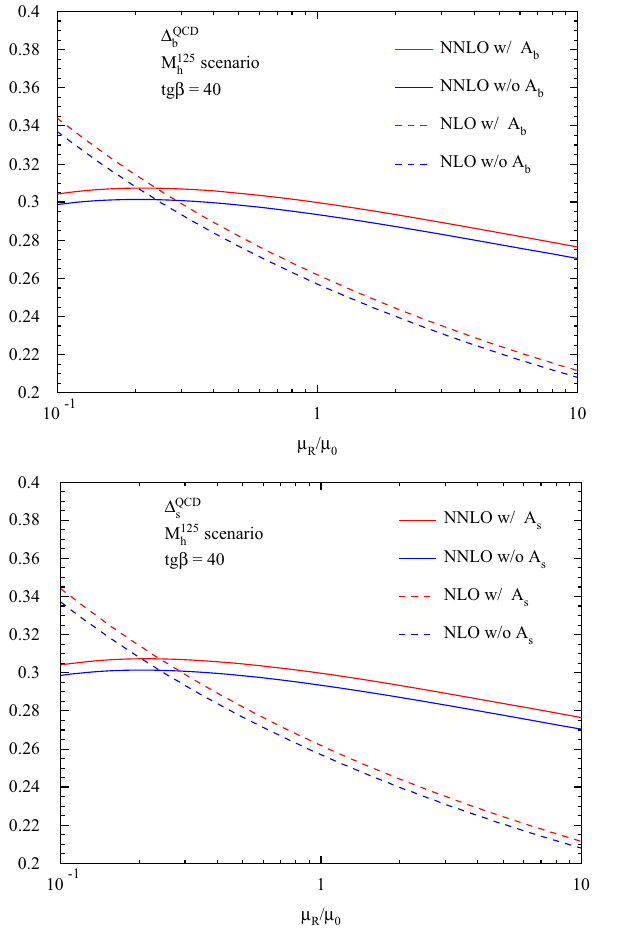
Fig. 8 Dependence of the full SUSY–QCD + SUSY–electroweak cor- Fig. 7 ScaledependenceoftheSUSY–QCDcorrections (cid:9) QCD (upper b rections (cid:9) b (upper plot) and (cid:9) s (lower plot) on tg β at one-loop and plot) and (cid:9) QCD s (lower plot) at one-loop and two-loop order with and two-loop order with and without the A b , A s contributions in the M 125 without the A b , A s contributions in the M 125 scenario h scenario, and the individual contributions to (cid:9) b and (cid:9) w, 1 / 2 tributions to (cid:9) el q , 2